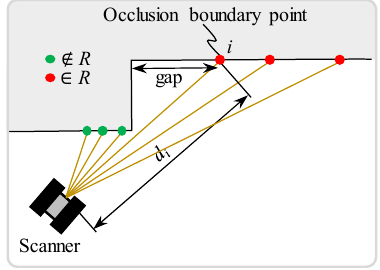
Figure 3. Occlusion boundary point